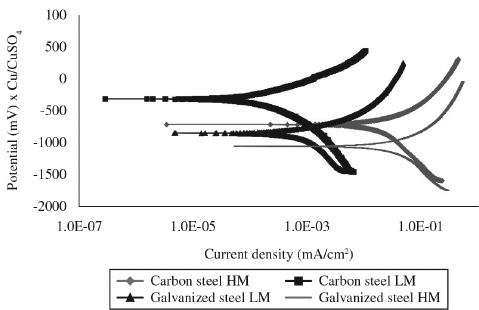
Figure 4. Corrosion potential monitoring (HM: High moisture e LM: Low moisture). Figure 5. Polarization curves in soil with different